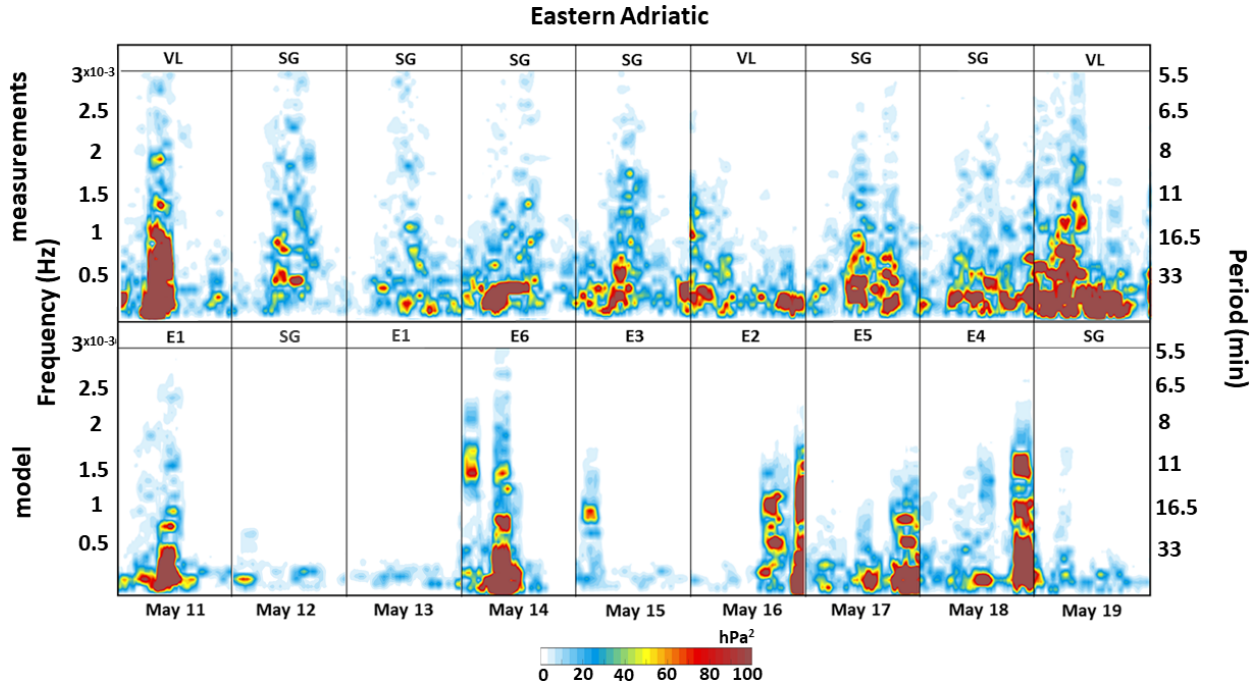
Figure 6. As in Fig. 4, but for the eastern Adriatic